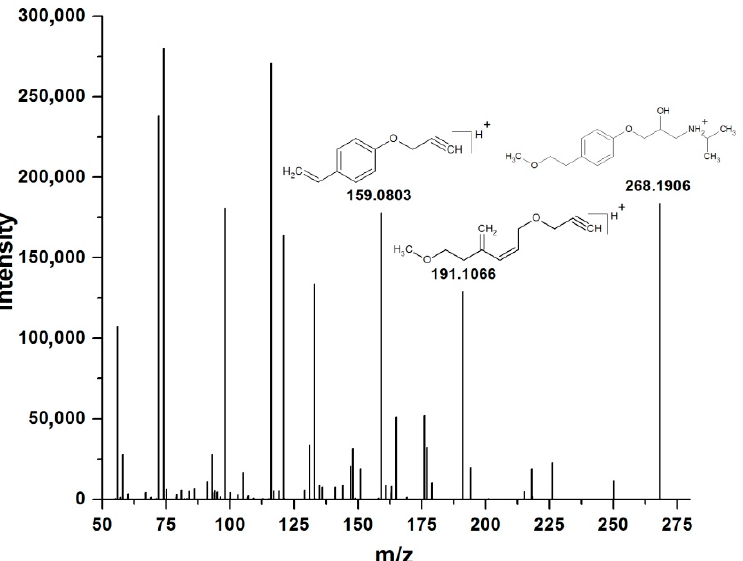
Figure 3. The mass spectrum of the IS as recorded by the PRM method. Fragment ions of the IS employed in this work are identified, and their masses are indicated.